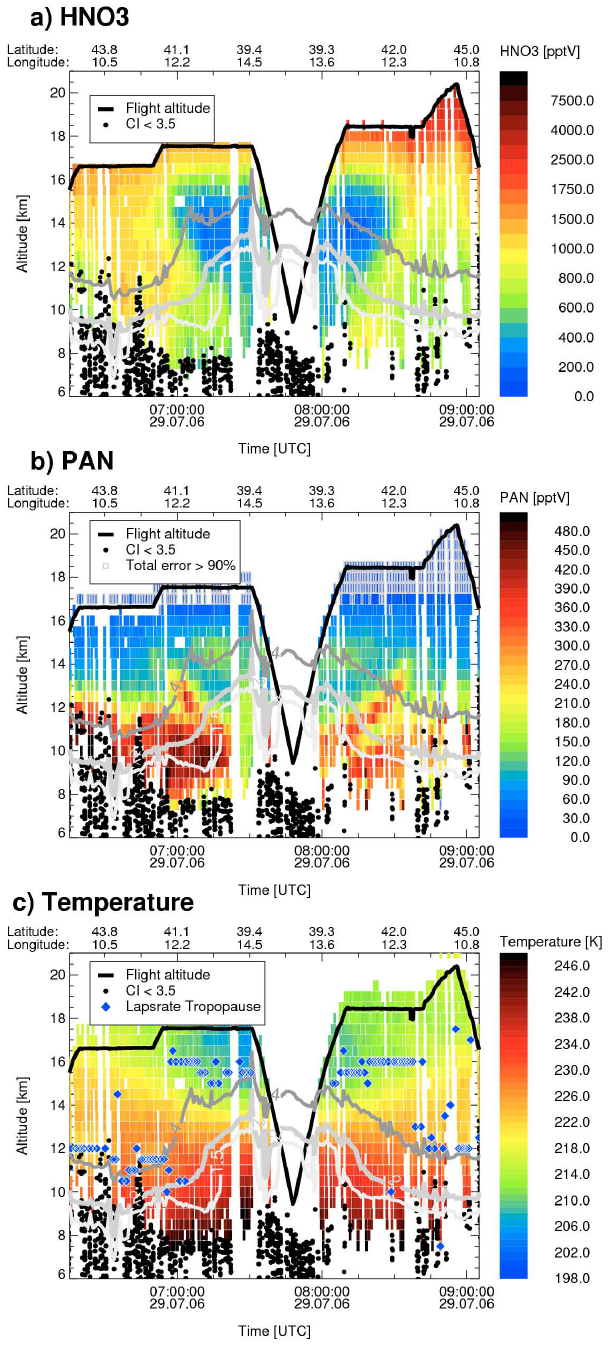
Fig. 5. CRISTA-NF retrieval results for HNO 3 , PAN, and Temper- ature. Grey lines show the ECMWF potential vorticity at 1.5, 2 and 4PVU, black line the flight track, black dots spectra with optical dense conditions, and grey diamonds retrieval results with a total error larger than 90%. Note nonlinear colour